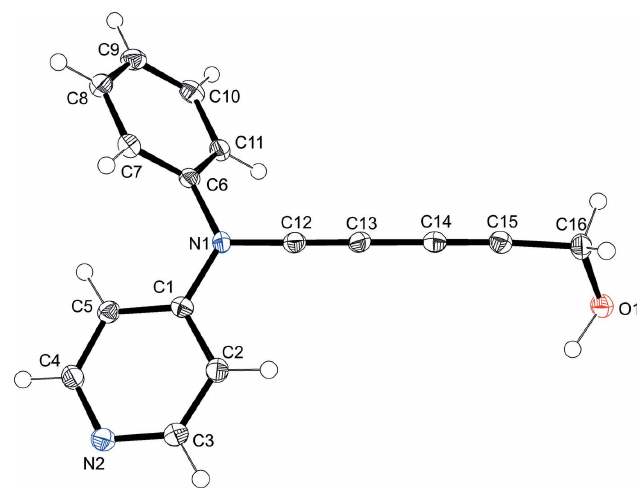
Figure 1 The molecular structure of the title compound with displacement ellipsoids drawn at the 50% probability level and H atoms are shown as small spheres of arbitrary radius.